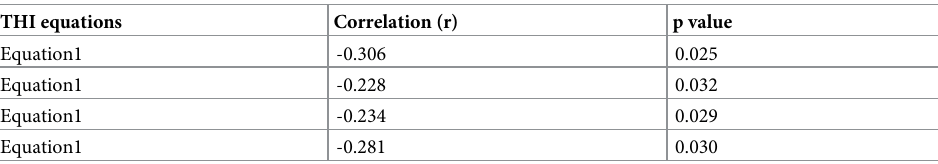
Table 2. Correlation and p value of four equations for calculating